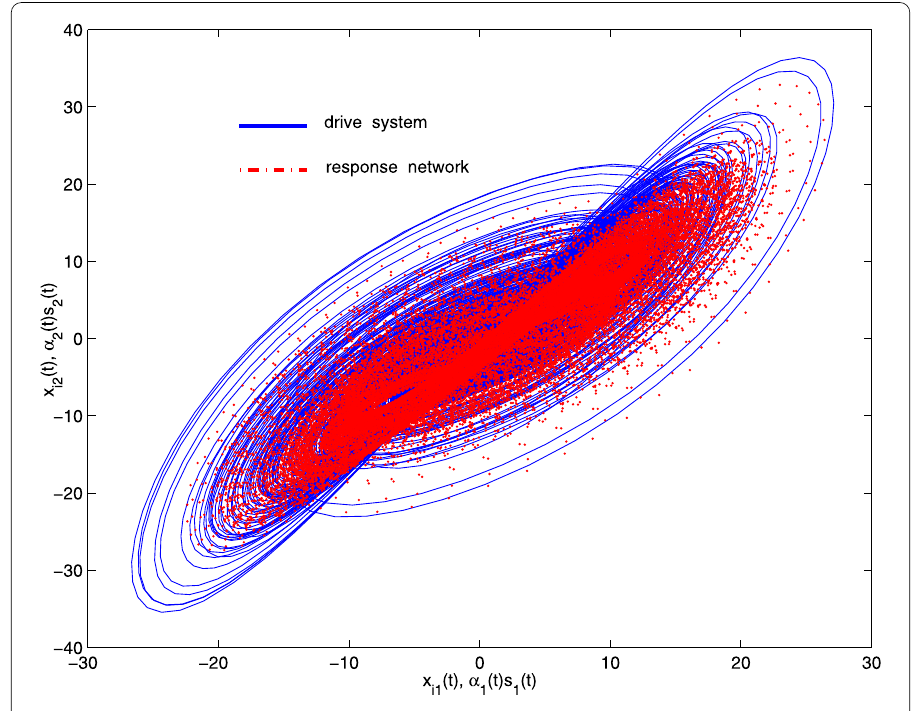
Figure 8 Chaotic behavior of drive system (40) and response network (41) with the time-varying scaling function matrix α ( t ) = diag(0.45 e sin( t ) ,0.5 e sin( t ) ,0.4 e sin( t )